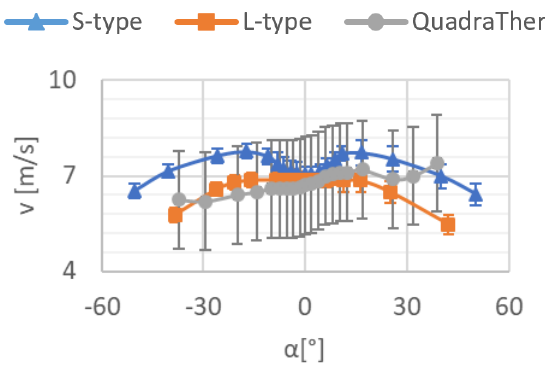
Fig. 20. S, L-type and QuadraTherm velocity probe declination measurement, mean velocity 7 m/s .